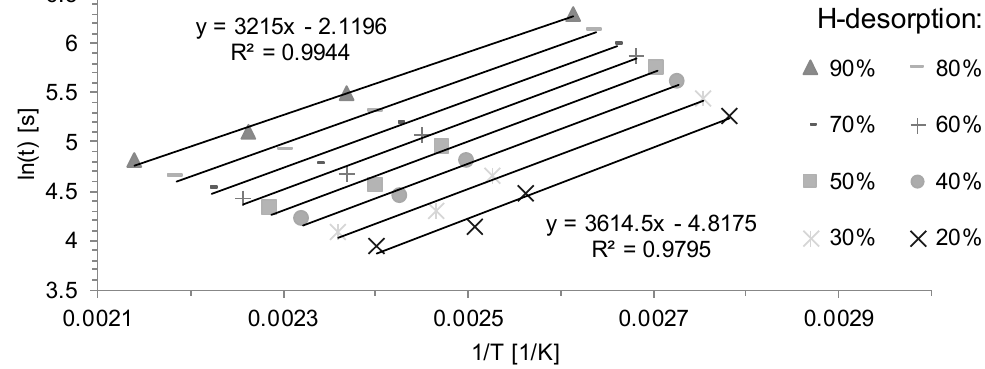
Figure 17. Representation of desorption times at different temperatures and desorption stages.